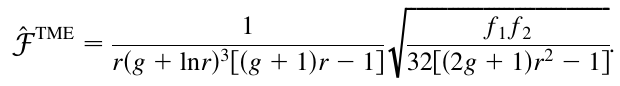
FIG. 2. Maximum TME emittance improvement factor as a =B . The blue dots are the exact values. function of (cid:12) ¼ B max ref The red curve is given by the approximate expression 1 = ^ F ð (cid:12) Þ ¼ (cid:1) 1 : 389 þ 2 : 981 (cid:12) (cid:1) 0 : 4428 (cid:12) 2 þ 0 : 040 12 (cid:12) 3 (cid:1) 0 : 001 437 (cid:12) 4 .